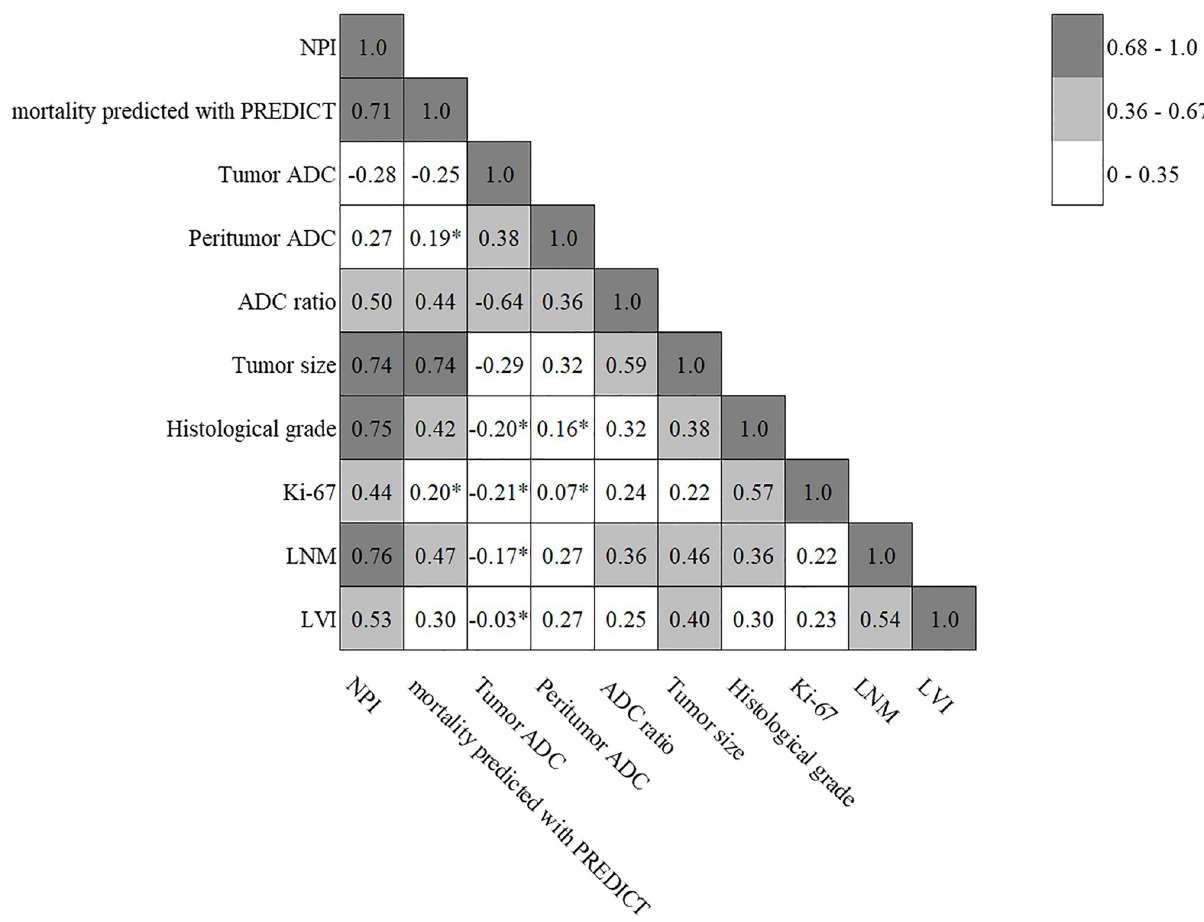
Fig 7. The cross correlation matrix of prognostic tools, tumor and peritumor ADC values, peritumor/tumor ADC ratios and histopathological parameters. Each value represents Pearson’s correlation coefficient. � ; statistically non-significant (p > 0.05).